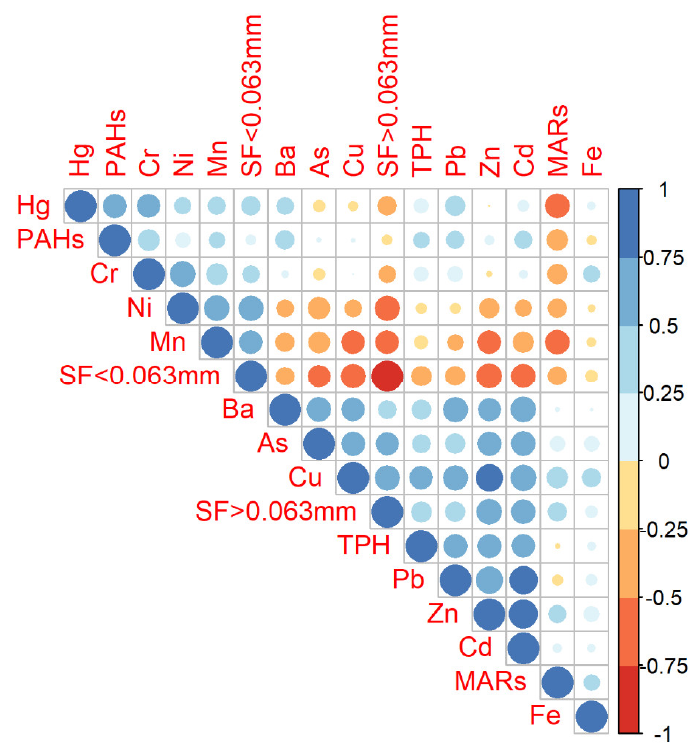
Figure 19. Correlation analysis between the sediments contamination levels detected and the mass accumulation rates (MARs) computed (Spearman rho, rank-based correlation coefficients). Consequently, the TSS associated with the PW discharges does not appear to be clearly related to the sediment contamination levels observed during the monitoring ac- tivities in the neighboring of the platforms selected (Table 2). 5. Conclusions To the best of our knowledge, this is the first study addressing the transport and fate of the particulate matter discharged in the marine environment with the PW plume gen- erated during offshore hydrocarbon extraction activity. The work was conceived to assess the potential contribution of the total suspended solid, associated with the PW effluent, to the sediment contamination observed in the Adriatic Sea during offshore platforms mon- itoring programs carried out so far. To this aim, we apply the hydrodynamic model MIKE 3 HD and the Lagrangian par- ticle model (MIKE 3 PT), using TSS in situ data collected during October 2017, to simulate one month PW discharge activity from two selected platforms located in the Adriatic Sea. The outcomes show that the fate of the TSS seems to be very similar for both platforms and is mainly affected by the particles size distribution and the environmental hydrody- namic conditions. In the investigated area close to the platform installations, the sediment is affected by the settling of the sand associated with the PW discharge and the TSS showed a negligible contribution to the total balance of material deposited annually on the seafloor. The present results also suggest that at the time and space scales investigated, even in the area close to the discharge point, the amount of TSS released with the PW determines a negligible increase in suspended particulate matter along the water column.